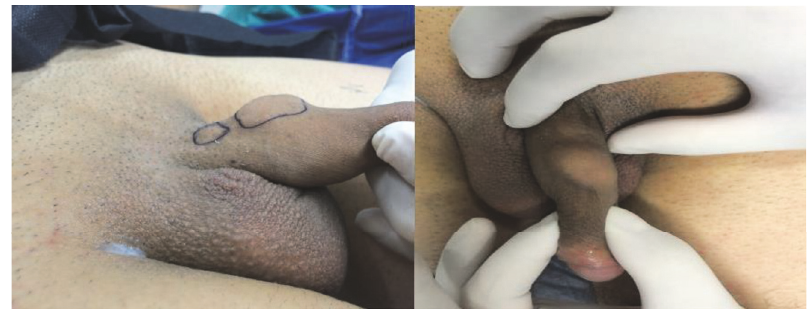
Figure 1: Two separate lumps on the dorsolateral aspect of the penis.